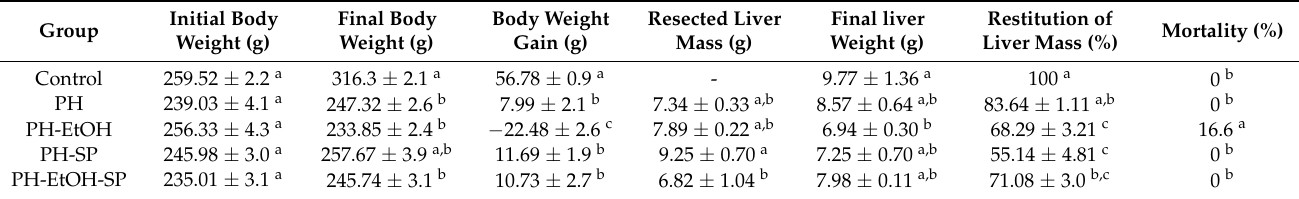
Table 1. Effect of the administration of EtOH and SP on body weight and survival in rats, and restitution of liver mass. Values are expressed as the mean ± standard error of the mean (SEM) in each experimental group (n = 6).